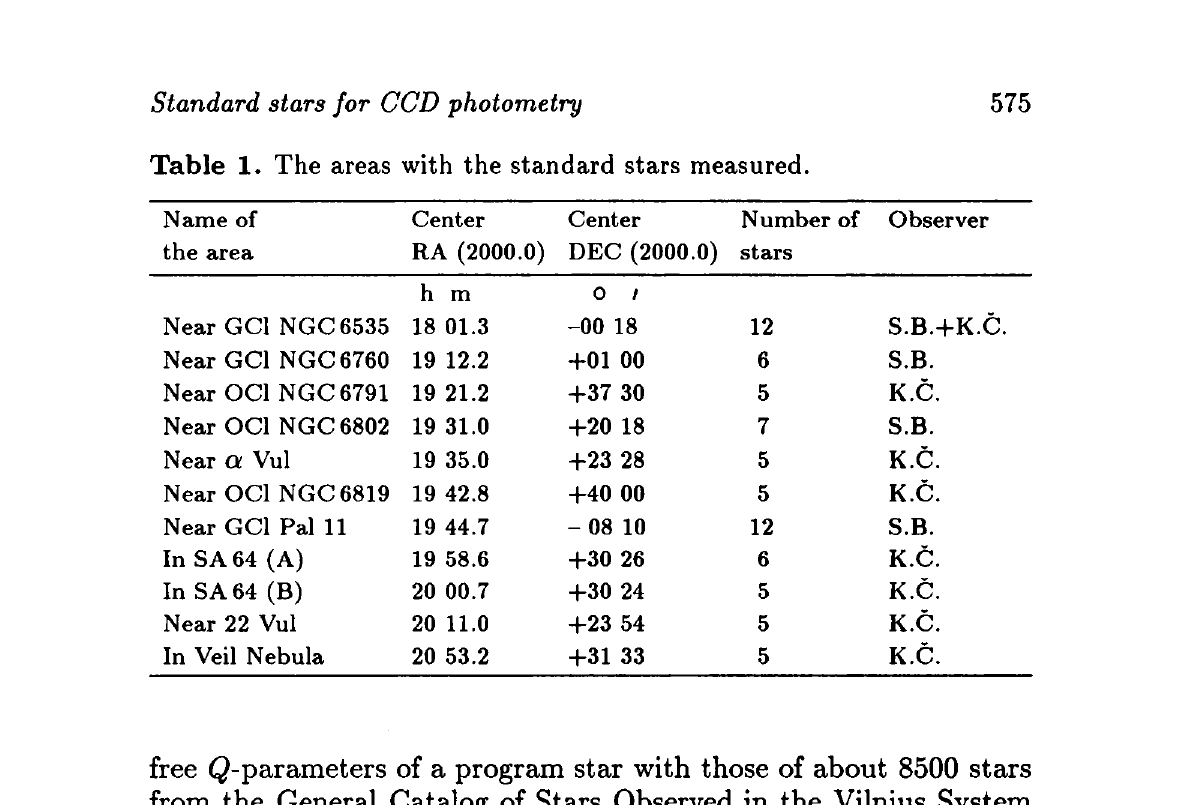
Table 1. The areas with the standard stars measured. Name of Center Center Number of Observer the area RA